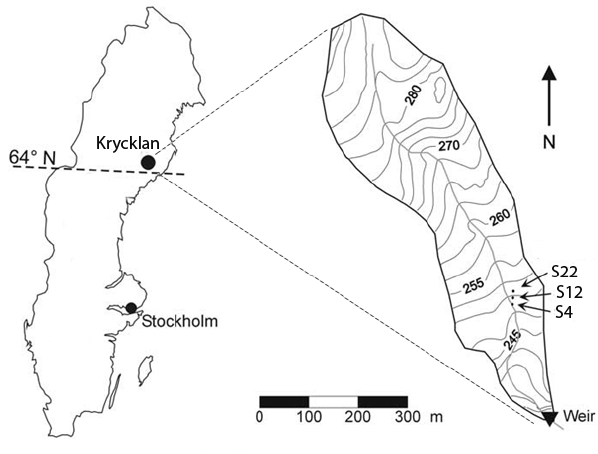
Figure 1. Map of Sweden showing the location of the Krycklan catchment (left) and the Västrabäcken (C2) catchment (right). The location of the sampling sites (S4, S12 and S22) in the investigated transect are shown along with the elevation above sea level (m). Note that the lysimeters are located along the flow direction of the groundwater and not perpendicularly to the